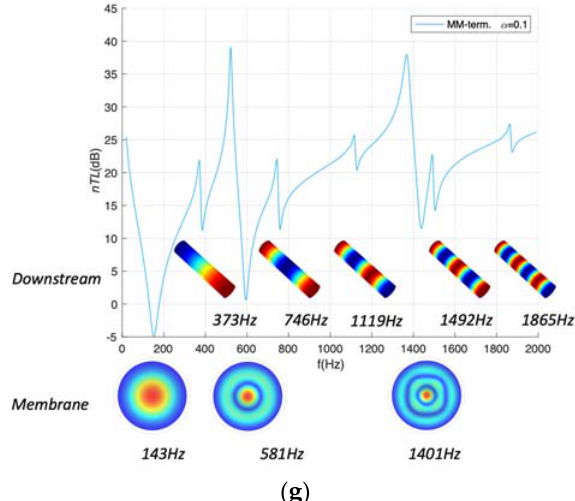
Figure 7. The nTL of 0.5 mm thin membrane determination by means of different methods from the FEM model for six different backing wall sound-absorption terminations (variation of termination absorption from α =0.1 to 1). ( a ) Seybert (Wave field decomposition method (WD)—one load); ( b ) Salissou (WD-TM hybrid method—two loads variations with termination (“term.” in the legend) absorptions denoted as α 1 , α 2 for first load and second load); ( c ) ASTM E261109 (“ASTM” in the legend, Transfer matrix method—single or two-load variations with different termination absorptions denoted as α 1 , α 2 for first load and second load variations); ( d ) mobility based method (MM—single load); ( e ) comparison of methods; ( f ) comparison of chosen cases by the difference in the frequency spectra ( ∆ nTL = nTL i − nTL ASTM α = 1 ); and ( g ) nTL spectra of calculated based MM, with termination α = 0.1. The figure also includes structural modes of the membrane as well as the acoustic modes of downstream tube causing the resonant phenomena in the spectrum.